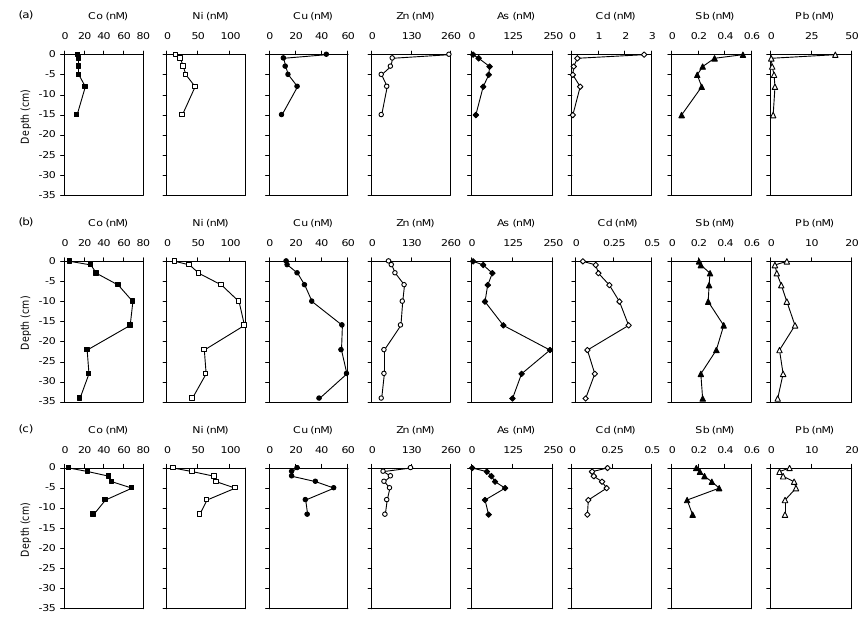
Figure 8 Audry et al. Fig. 8. Concentration–depth profiles for trace elements in the porewater of Lake Shirokoe (a) , Lake Yamsovey (b) and Lake Khasyrei (c) .